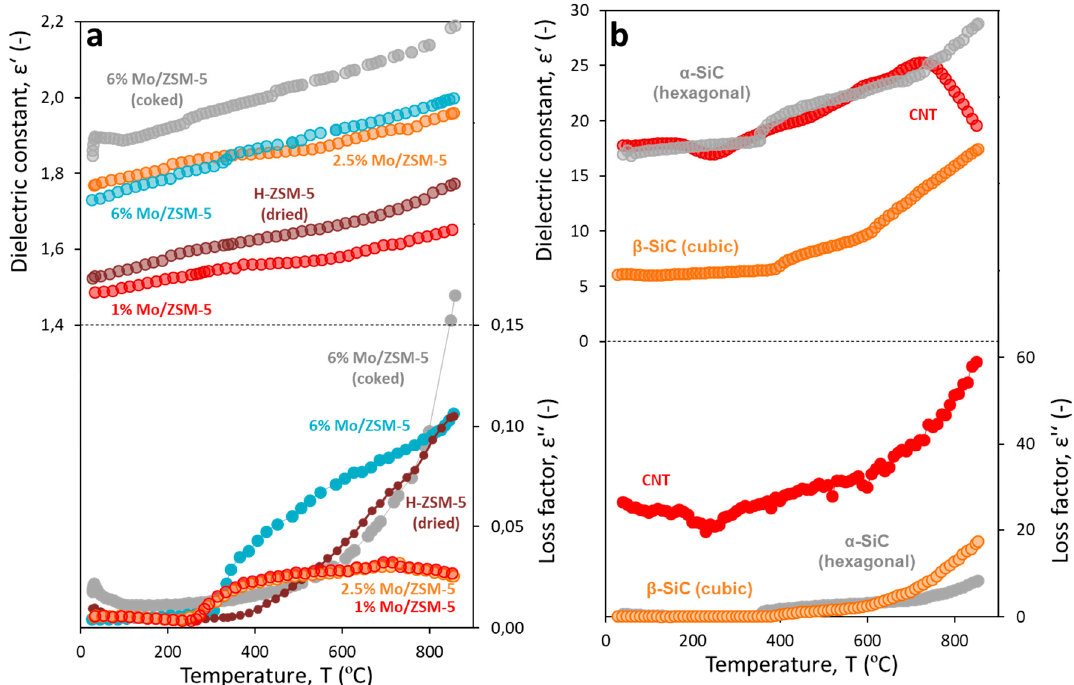
Figure 1. Dielectric properties of: ( a ) fresh and spent catalytic Mo / ZSM-5 powders (benchmarking catalyst for MNOC process), ( b ) carbon nanotubes (Baytubes ® C 70 P) and SiC powders (100–250 µ m) with different crystalline phases (cubic and hexagonal).